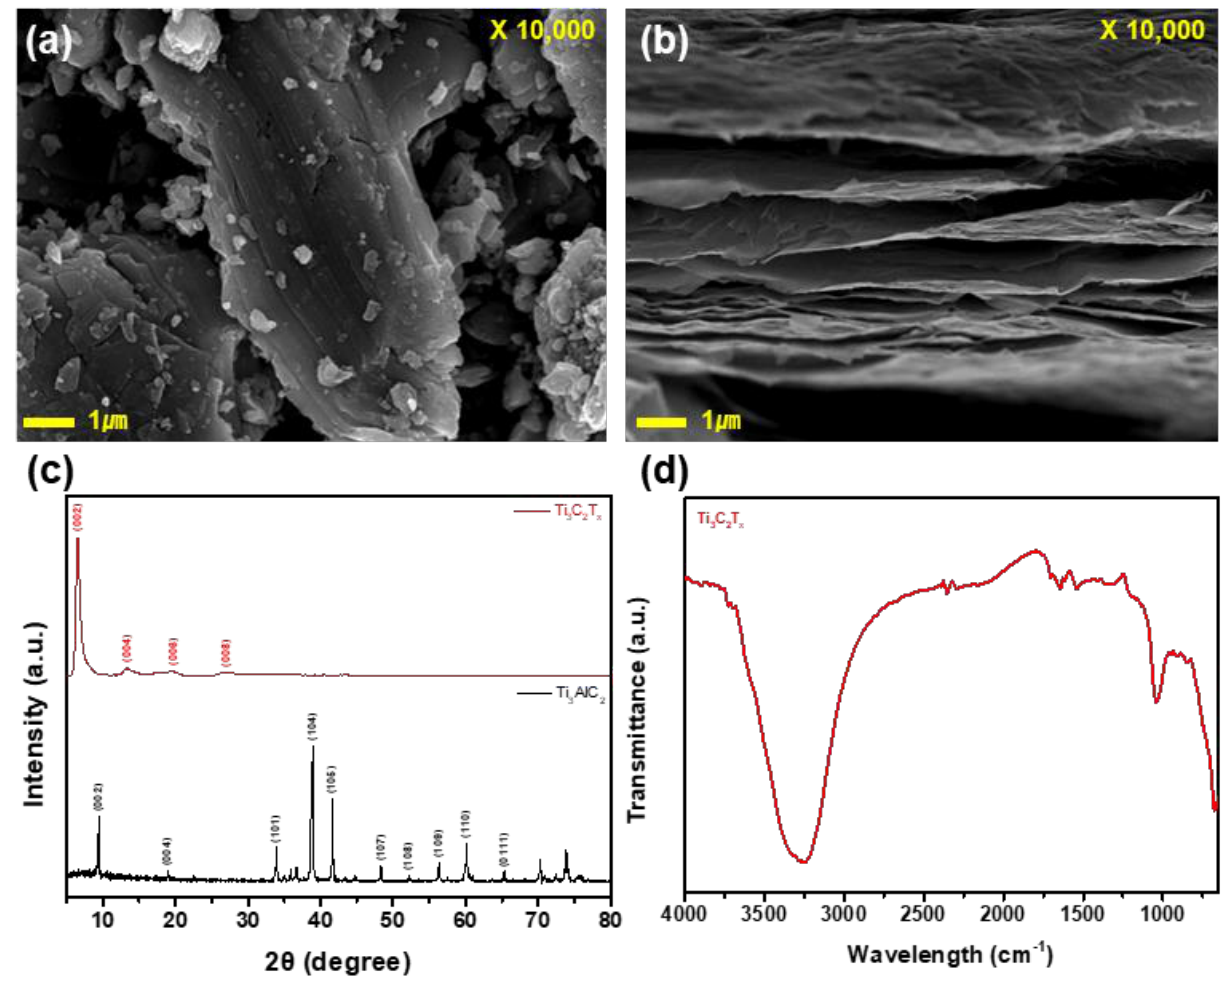
Figure 2. SEM images of ( a ) MAX phase, ( b ) Ti 3 C 2 T x MXene, ( c ) XRD patterns, and ( d ) ATR-FT-IR spectra of the Ti 3 C 2 T x MXene.